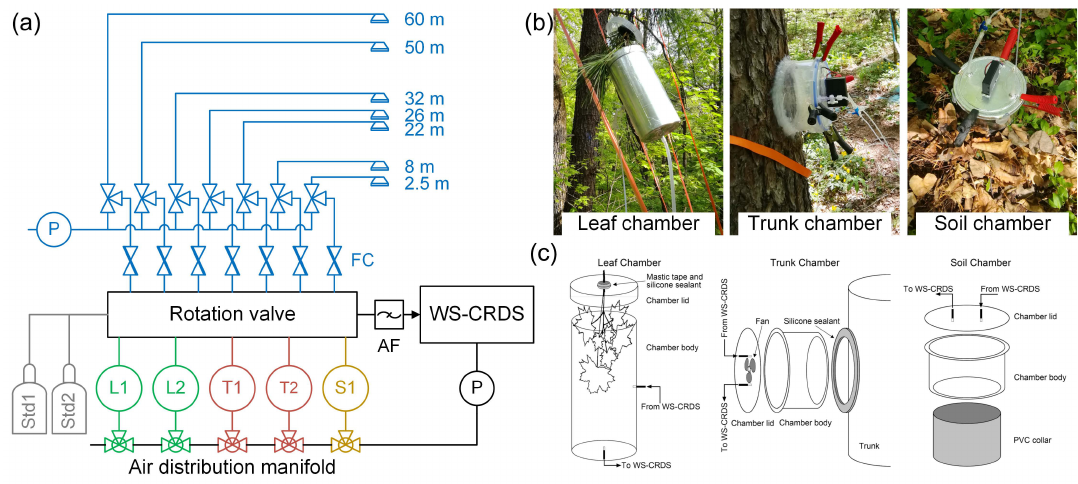
Figure 1. Schematic of the atmospheric profile and respiration chamber system ( a ) and photographs ( b ) and diagrammatic representations ( c ) of the custom-made chambers. L1 and L2, leaf chambers; T1 and T2, trunk chambers; S1, soil chamber; Std1 and Std2, standard gas tanks; FC, flow controller; AF, air filter; P,